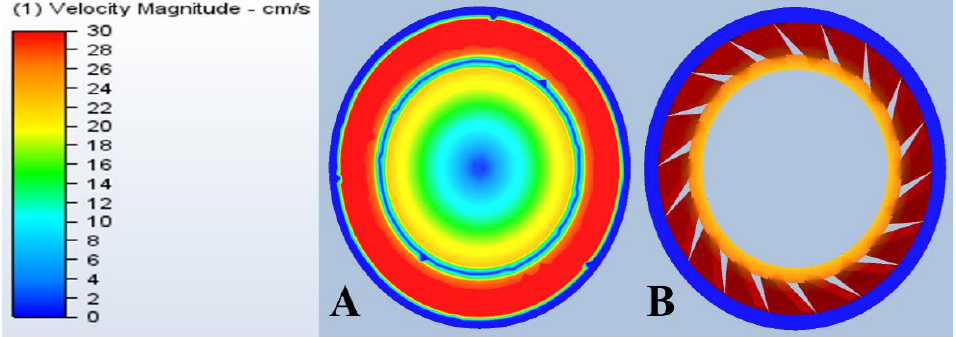
Figure 11 . Ultrafiltration cell velocity profiles on ( A ) the surface of the membrane and ( B ) on the surface of the